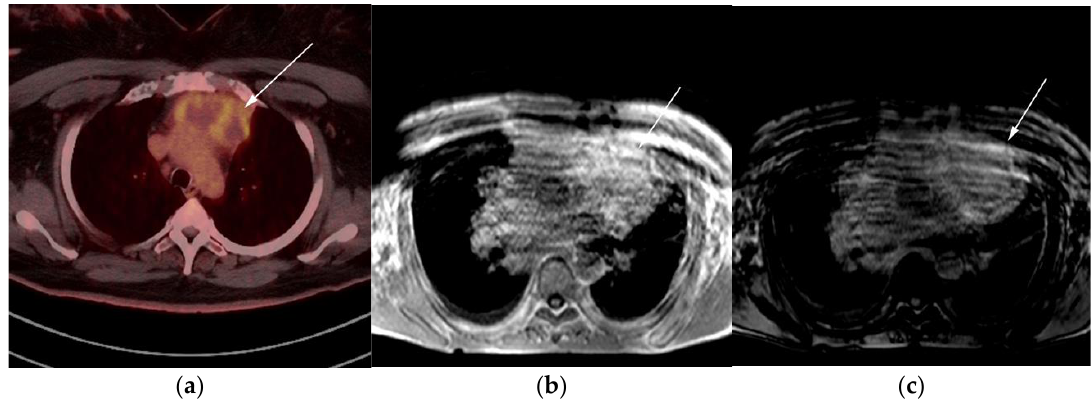
Figure 8. Imaging in a 60-year-old female presenting with ill-defined anterior mediastinal mass. ( a ) Axial 18F-FDG PET/CT showing ill-defined hypermetabolic mass within the anterior mediastinum (arrow). This was biopsy-proven thymic carcinoma. ( b ) MRI T1 in phase sequence, ( c ) MRI T1 out of phase—note there is no dropped signal on the T1 out of phase (arrows) due to lack of fat. This is consistent with residual disease.